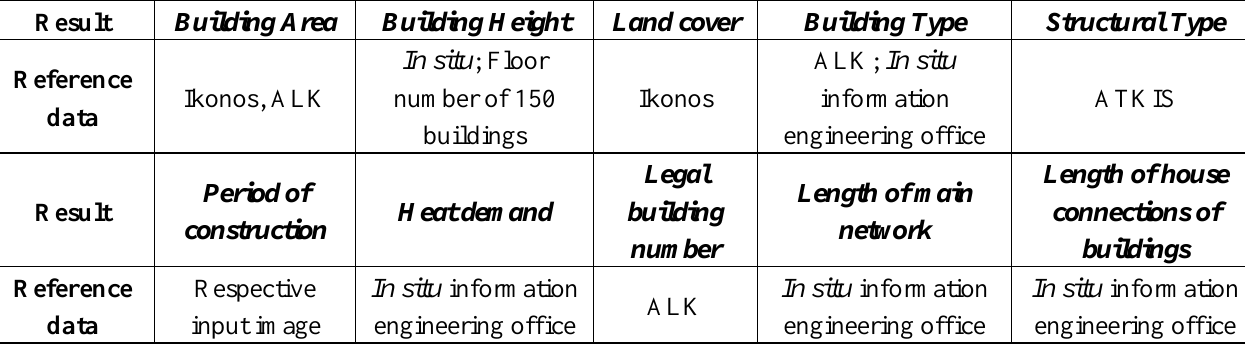
Table 5. Results and respective reference data